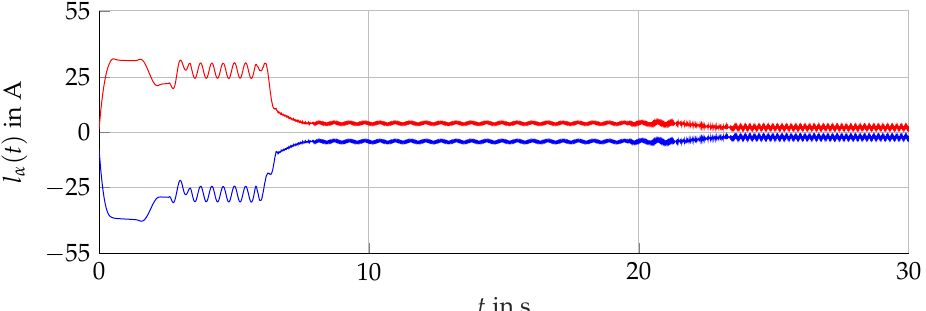
Figure 14. Interval boundaries i µ , α ( t ) (red) and i µ , α ( t ) (blue) of the bundle of observers B of the scenario with measurement data.